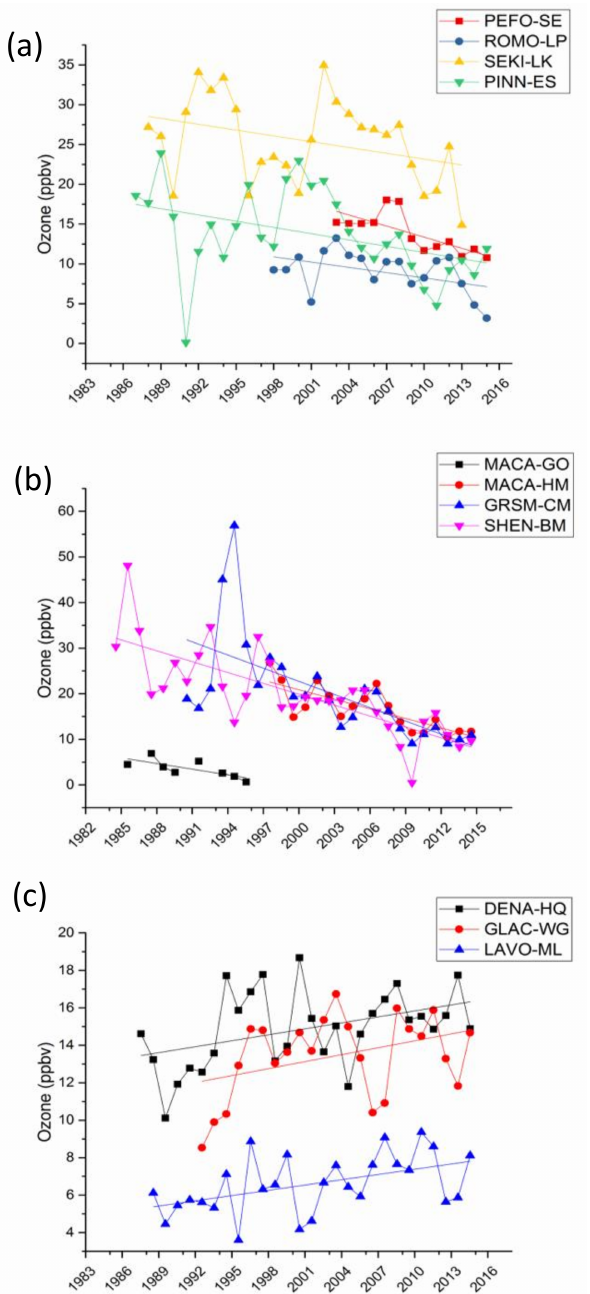
Figure 4. Sites with a significant negative change in annual amplitude for western ( a ) and eastern sites ( b ) and a significant positive change in annual amplitude ( c